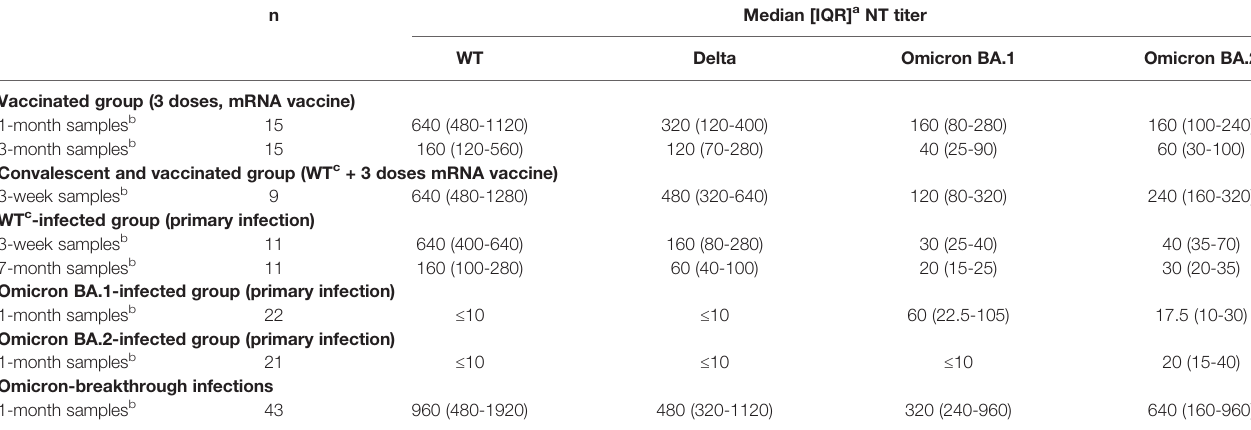
TABLE 2 | Serum-neutralization titers of cohorts analyzed in this study. n Median [IQR] a NT titer WT Delta Omicron BA.1 Omicron BA.2